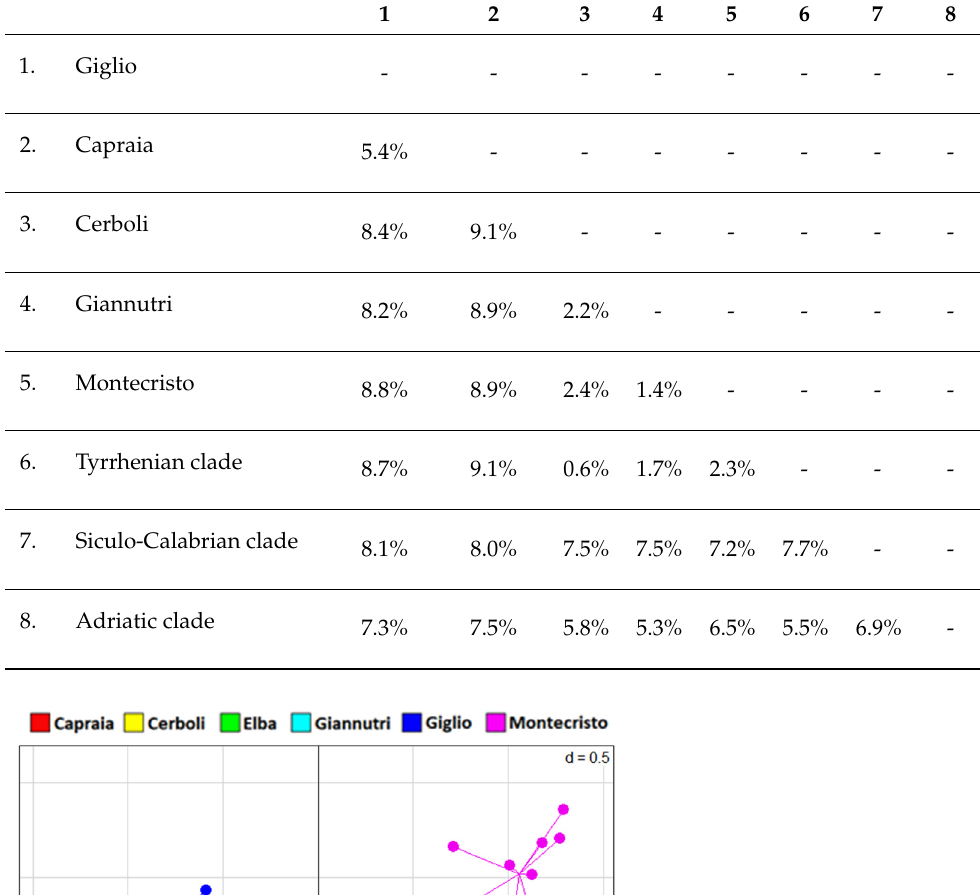
Table 4. Mean p-distances between Podarcis siculus populations of the Tuscan Archipelago and clades (sensu Senczuk et al. [25]) according to our cytb analysis. The Tyrrhenian clade includes all the available sequences from continental Tuscany.